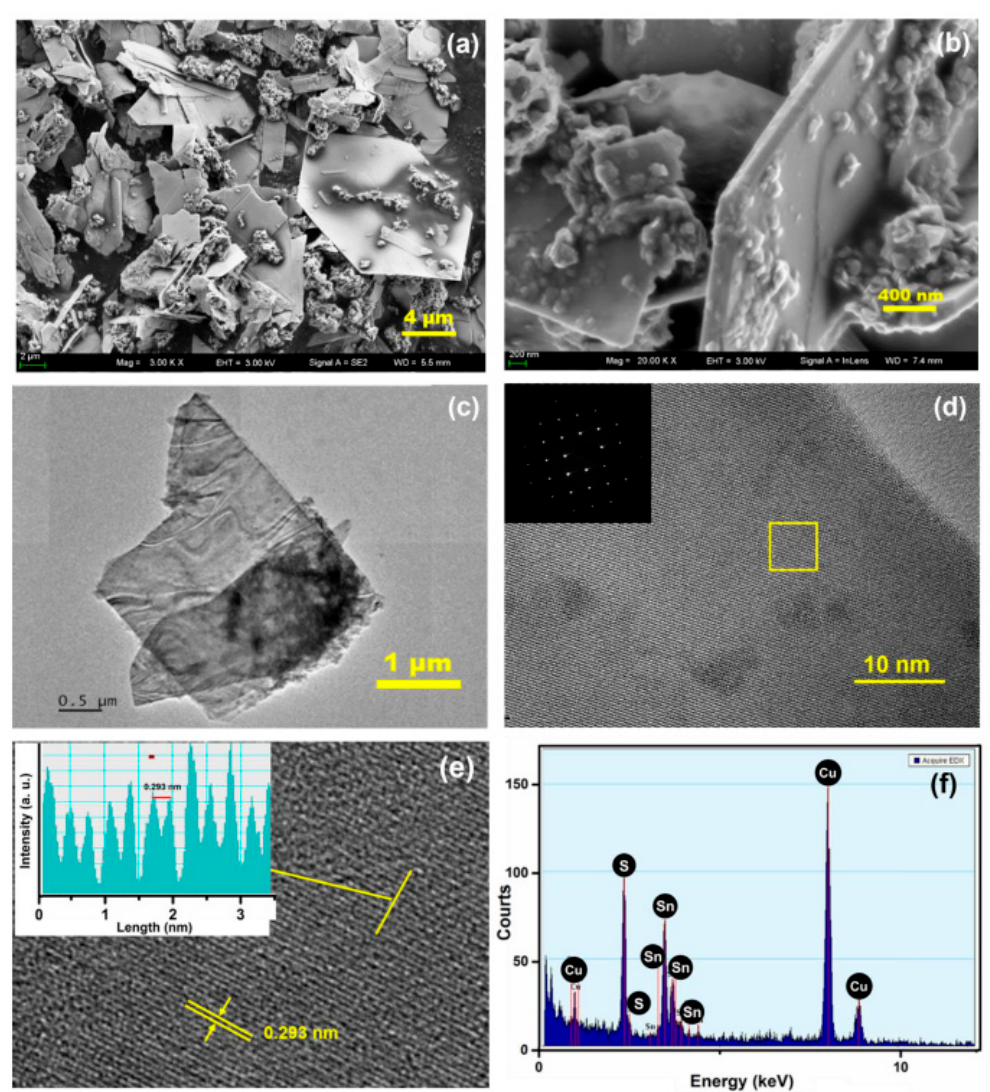
Figure 4. ( a ) and ( b ) SEM images of SnS nanosheets. ( c ) TEM image of SnS nanosheets. ( d ) and ( e ) HRTEM images of SnS nanosheets. ( f ) The EDX spectrum of SnS nanosheets.